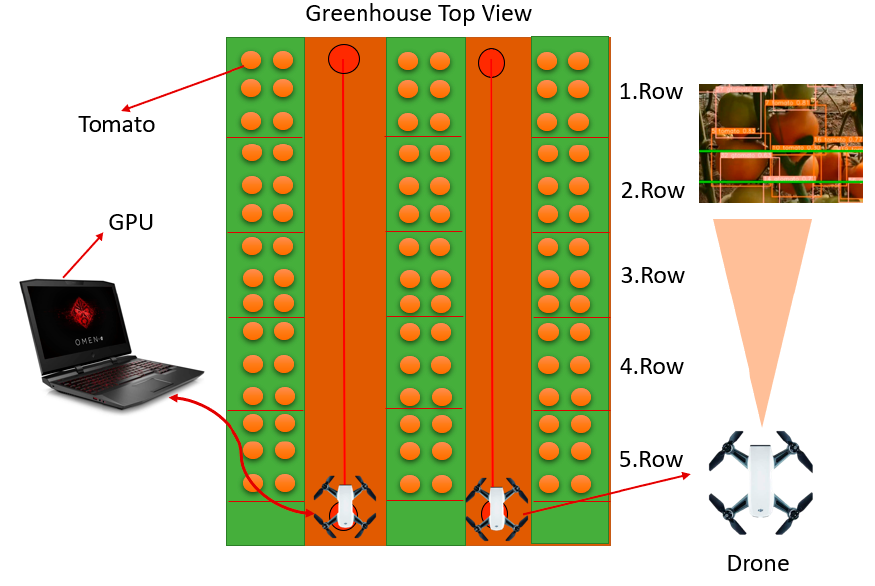
Figure 4. Equipment Setup.